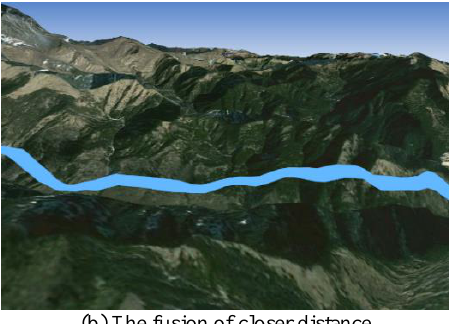
Figure 8. View frustum of vector objects